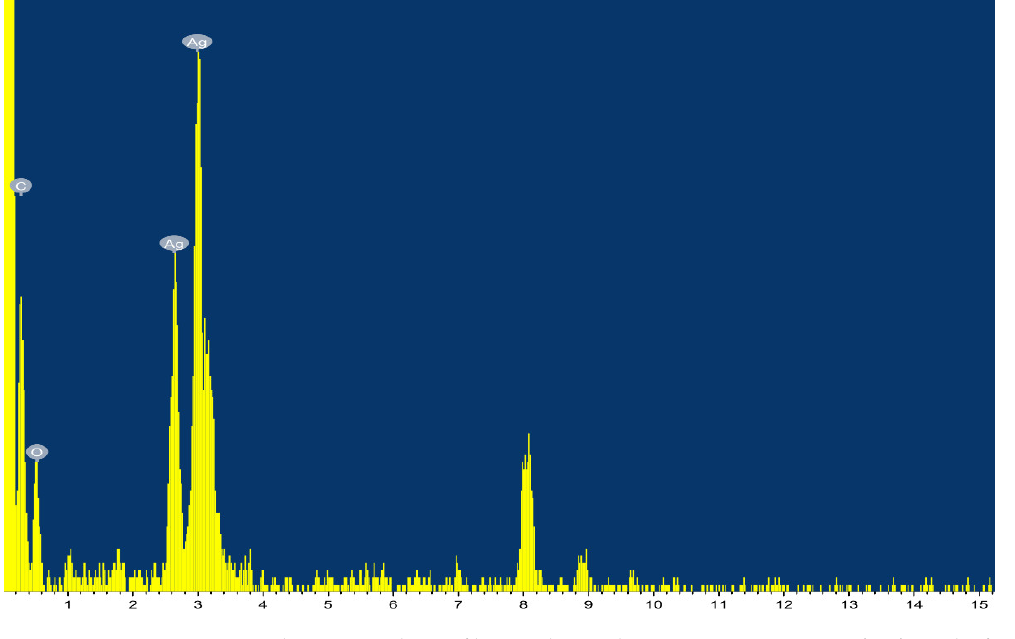
Figure 3. The EDX analysis of biosynthesized Ag-NPs using Ocimum basilicum leaf extract as reduc- ing agents.